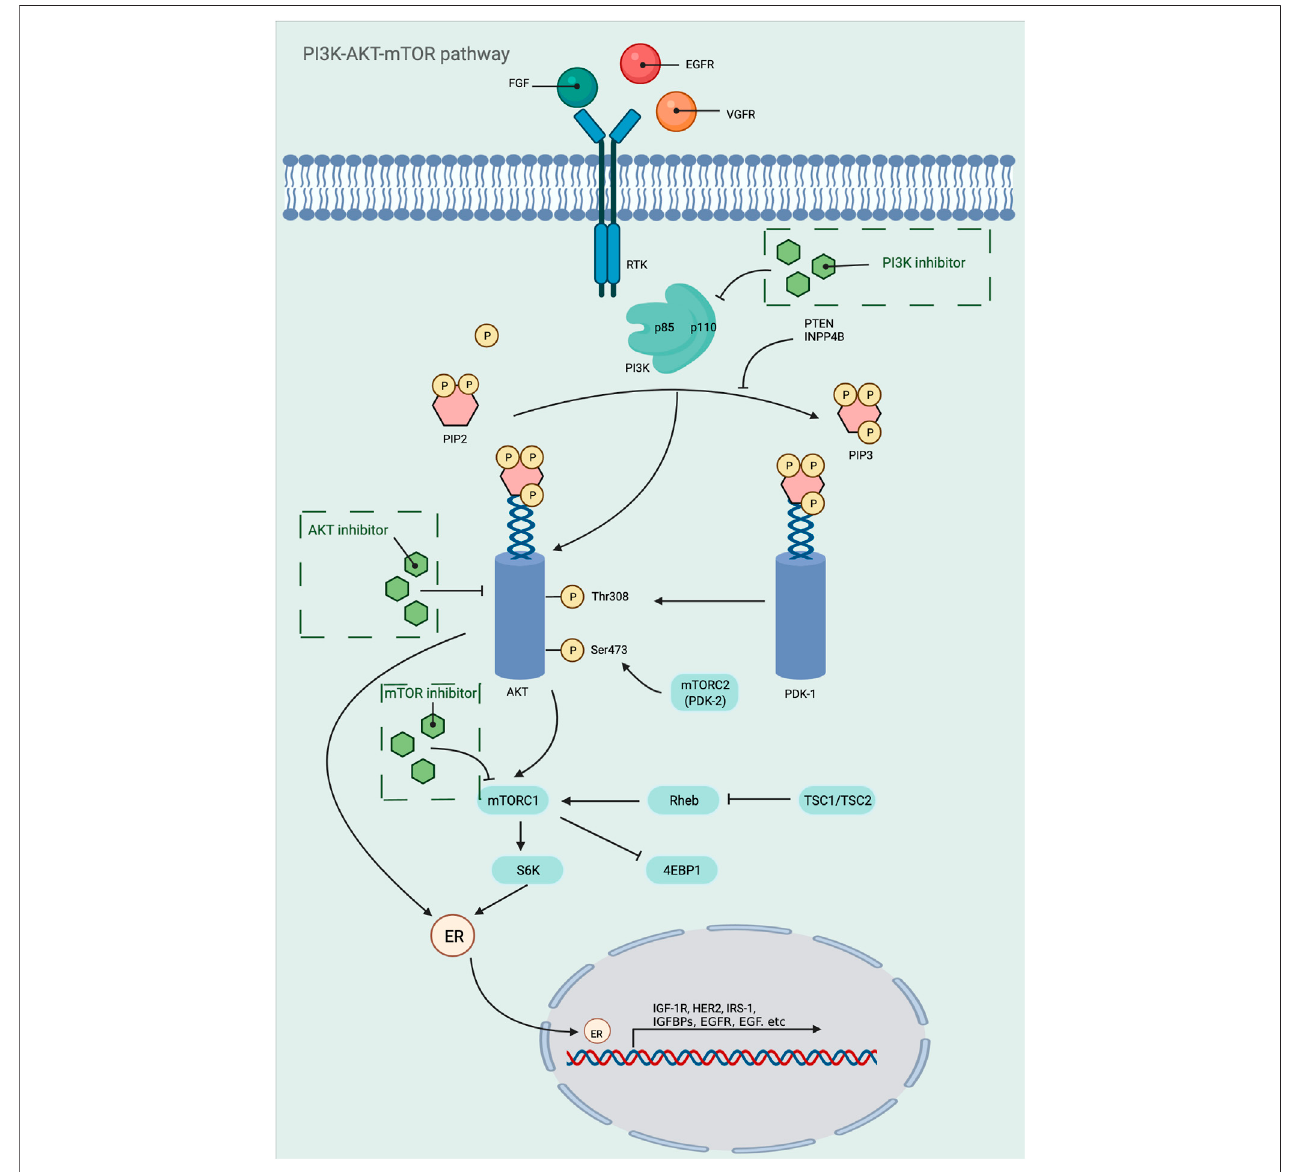
FIGURE 3 | Mechanistic map of the PI3K-AKT-mTOR signaling pathway. EGF, epidermal growth factor; EGFR, epidermal growth factor receptor; FGF, fi broblast growthfactor;HER2,humanepidermalgrowthfactorreceptor-2;IGFBP,insulin-likegrowthfactor-bindingprotein;IGF-1R,insulin-likegrowthfactor1receptor;INPP4B, inositol polyphosphate 4-phosphatase type Ⅱ ; IRS-1, insulin receptor substrate 1; PDK, phosphoinositide-dependent protein kinase; PTEN, Phosphatase and tensin homologue deleted on chromosome 10; Rheb, Ras homolog enriched in brain; TSC, tumor stem cell; VGFR, vascular endothelial growth factor; 4EBP1, e IF4E- binding protein 1. The fi gure is created with